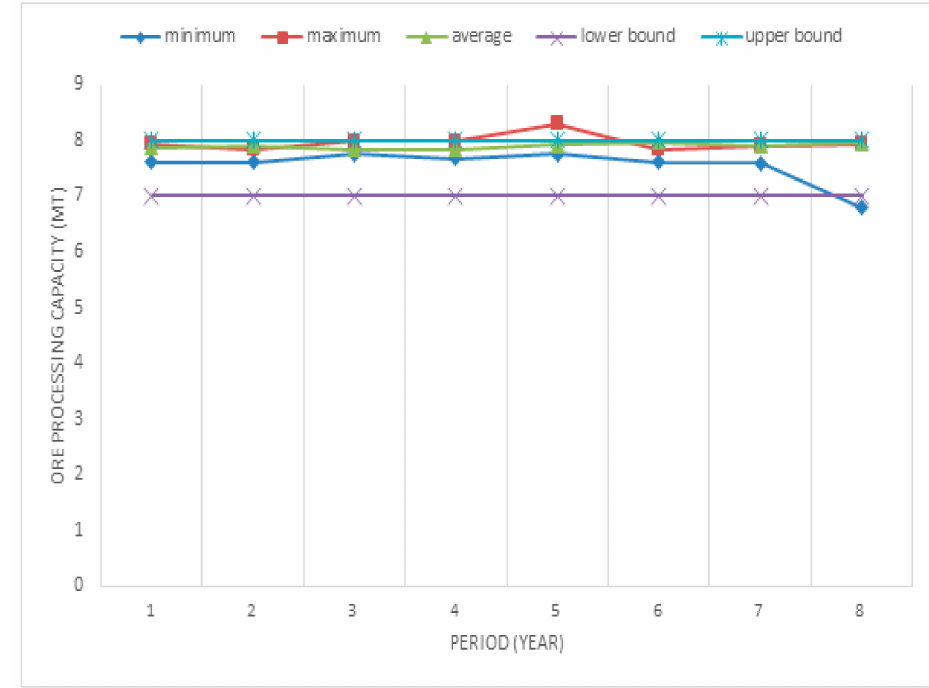
Figure 9. Ore production capacity of the production schedule.